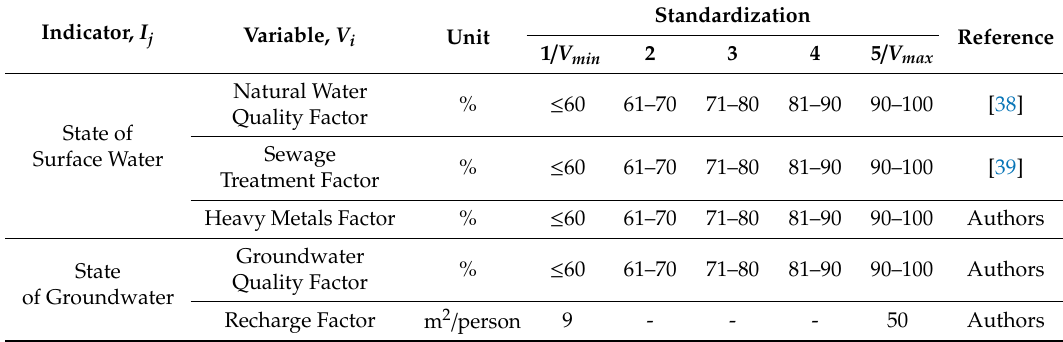
Table 5. Benchmarking variables for environment and ecosystem